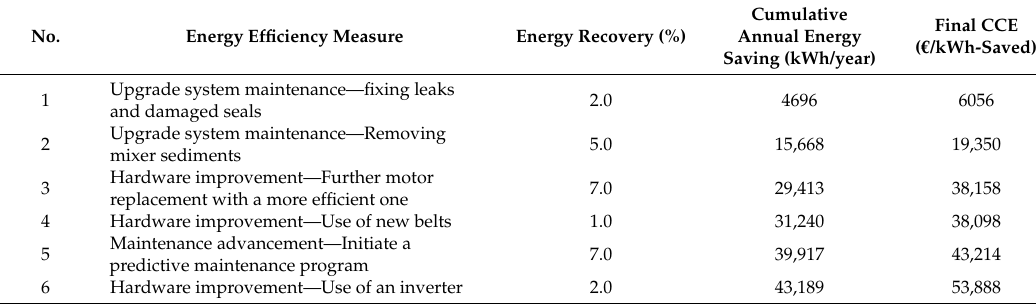
Table 6. Cumulative annual electricity saving by proposed measures. No.